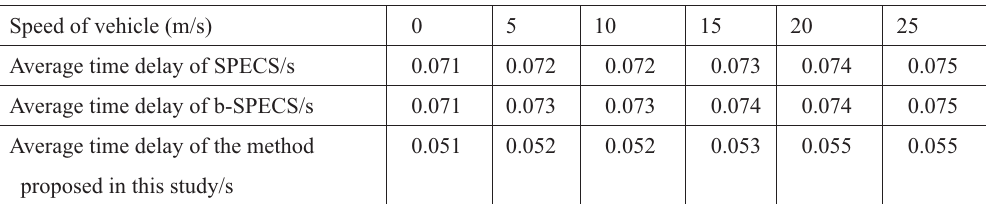
Table 4. Influence of vehicle speed on the average time